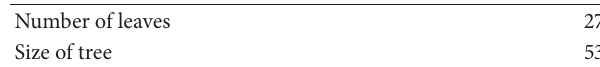
Table 6: Classification results of 600 user datasets.